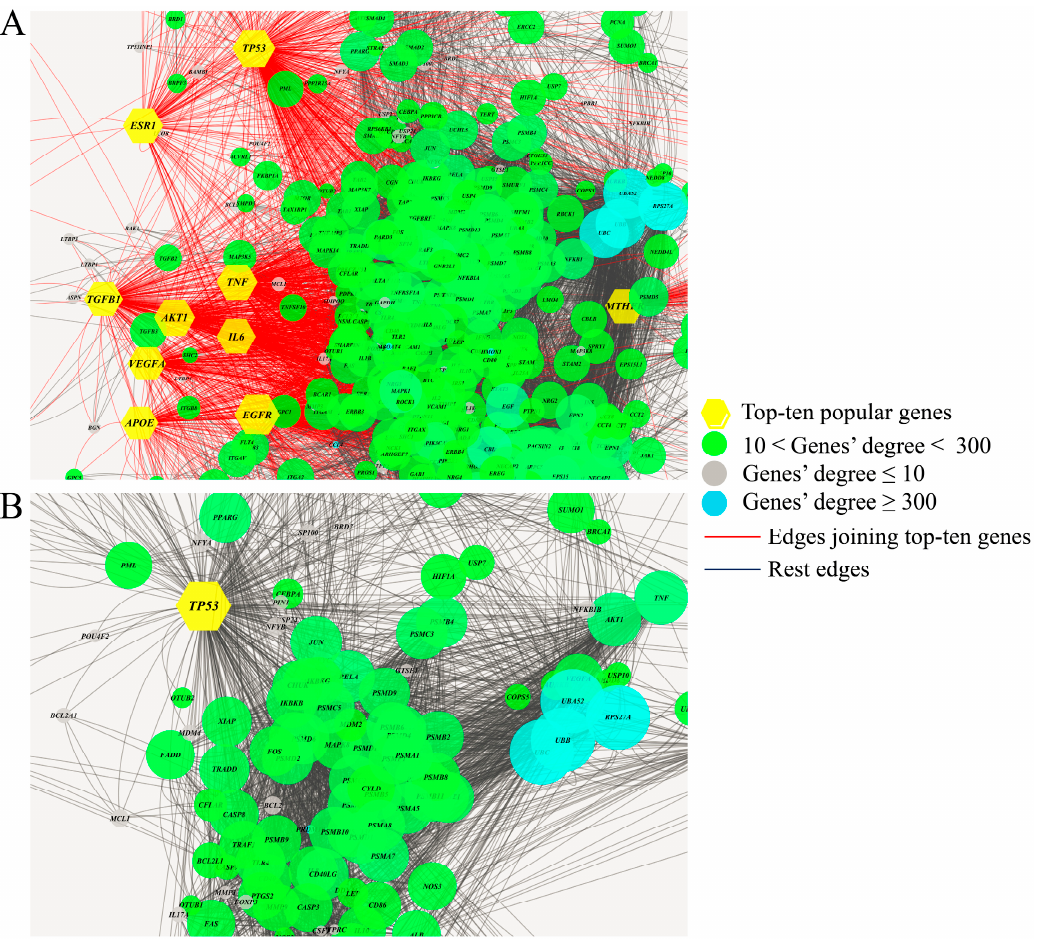
Figure 4. The network of ten popular disease genes and their first-order neighbor genes. ( A ) The top-ten popular genes and their nearest neighbors. ( B ) TP53 and its neighbor genes.